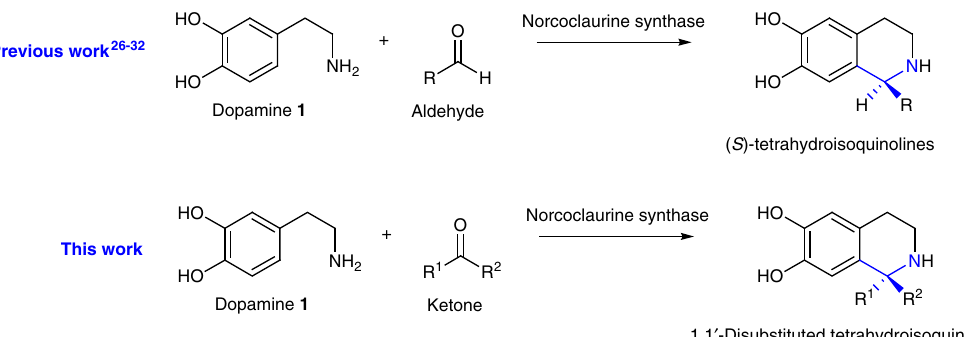
Figure 2 | Norcoclaurine synthase activities. Previous work using NCSs demonstrated biocatalytic formation of 1-monosubstituted-THIQs from dopamine and aldehydes. In this work we demonstrate the biocatalytic route to 1,1 0 -disubstituted THIQs, from dopamine and ketones, via a Pictet–Spengler reaction, catalysed by NCS. The amines and substituted alpha-carbons is highlighted in blue.